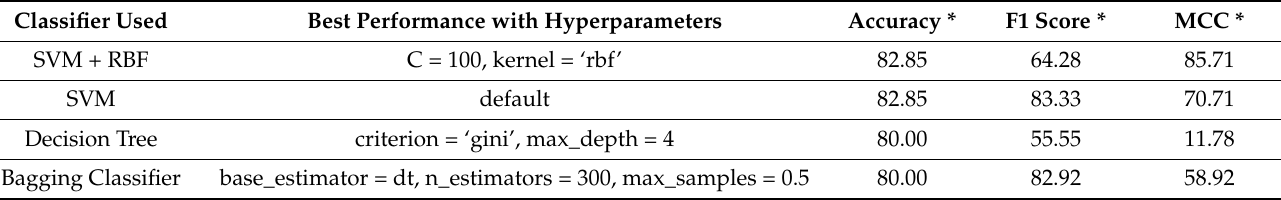
Table 2. Estimated performance over Dataset-1 under